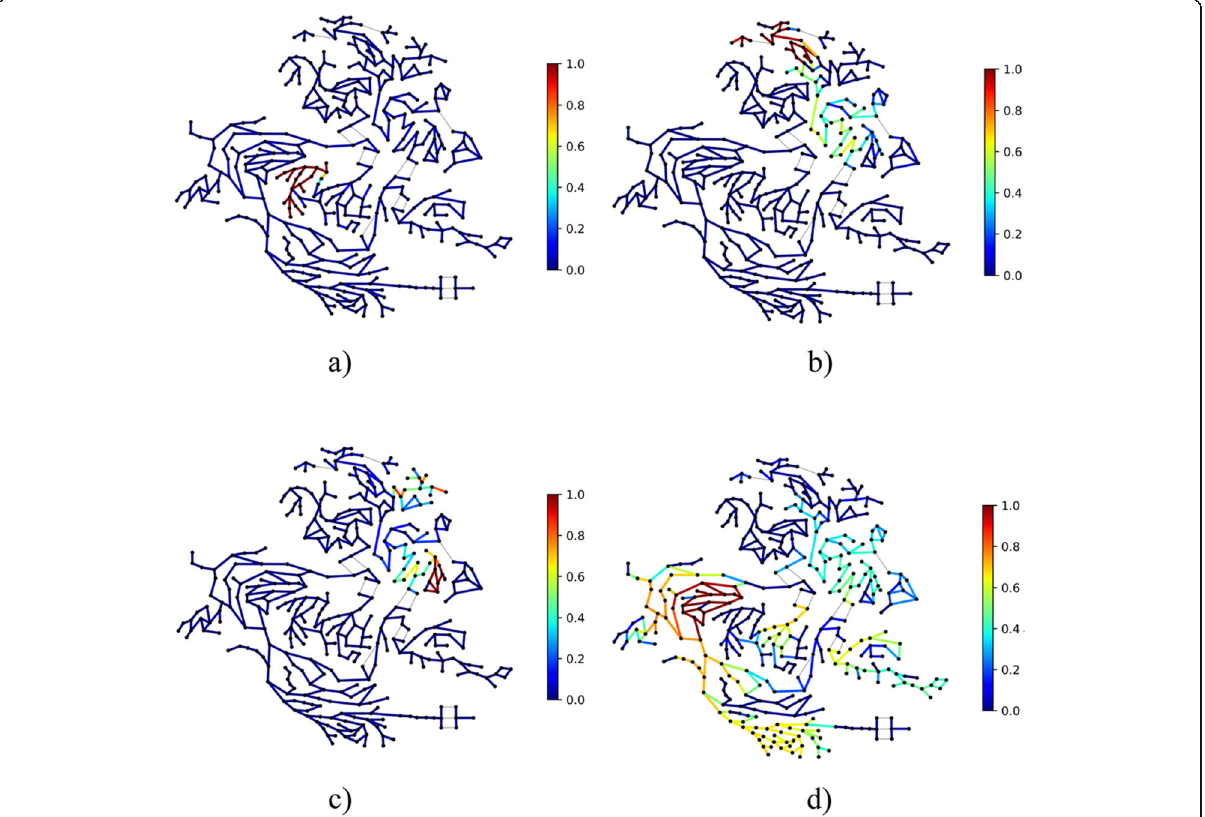
Fig. 19 The probability of leak alert by AE detection model when leak happens on pipe in the WSN: a Monitoring sensors located in area a of C- town, c Monitoring sensors located in area b of C-town, c Monitoring sensors located in area c of C-town, d Monitoring sensors located in area d of